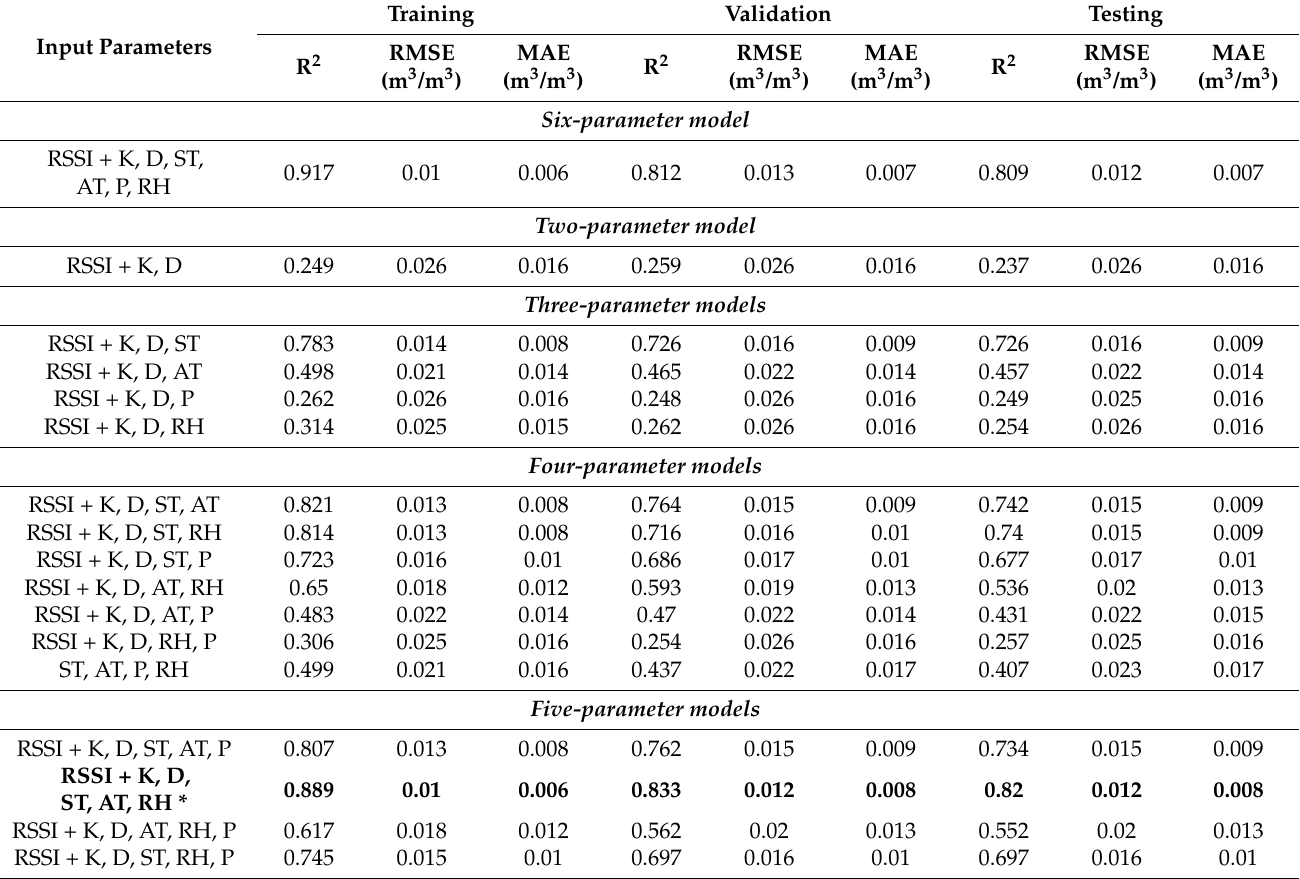
Table 2. Results of ANN–MLP model with different input parameter